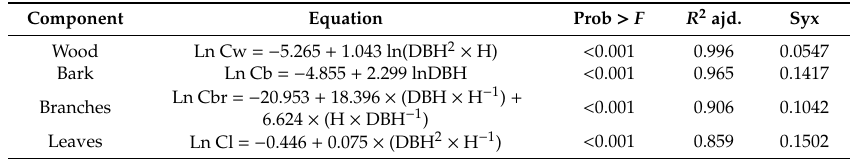
Figure 1. Observed and estimated amounts of carbon in the 10-year-old Eucalyptus urophylla × Eucalyptus globulus stand. Table 3. Carbon equations for di ff erent components of the 10-year-old Eucalyptus urophylla × Eucalyptus globulus stand. Cw is carbon in wood (kg tree − 1 ), Cb is carbon in bark (kg tree − 1 ), Cbr is carbon in branches (kg tree − 1 ), and Cl is carbon in leaves (kg tree − 1 ). DBH is diameter at breast height (cm) and H is total tree height